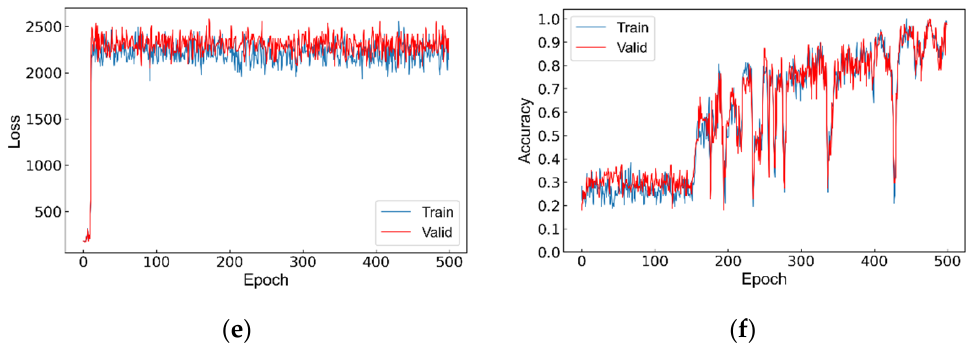
Figure 9. Using SGD to train the model with different learning rates. ( a , b ) learning rate = 1 × 10 − 3 ; ( c , d ) learning rate = 1 × 10 − 4 ; ( e , f ) learning rate = 1 × 10 − 5 .